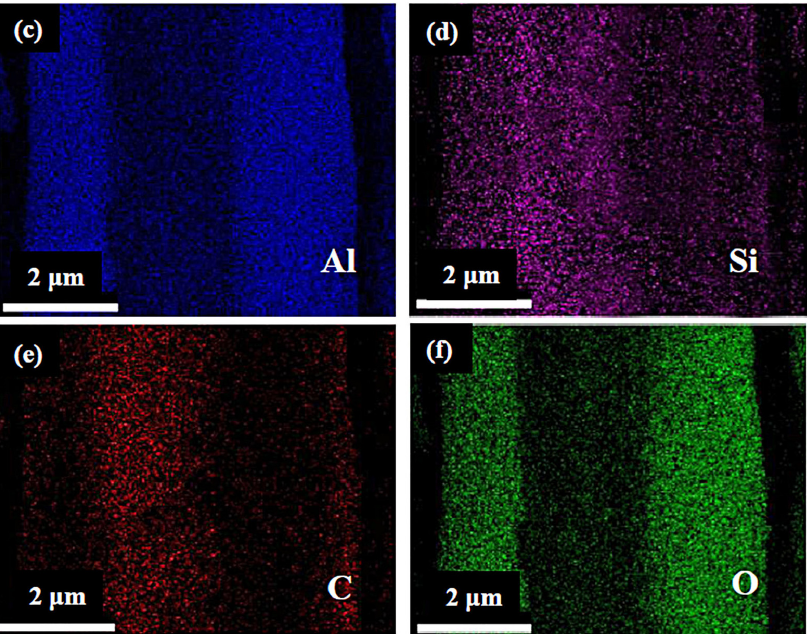
Figure 5. The energy dispersive spectrometry (EDS) mapping analysis of the cross ‐ section oxide scale of Al 4 SiC 4 crystal at 1600 ◦ C. ( a ) the enlarged SEM image of the cross-section; ( b )~( f ) the distribution of respective element with different color.